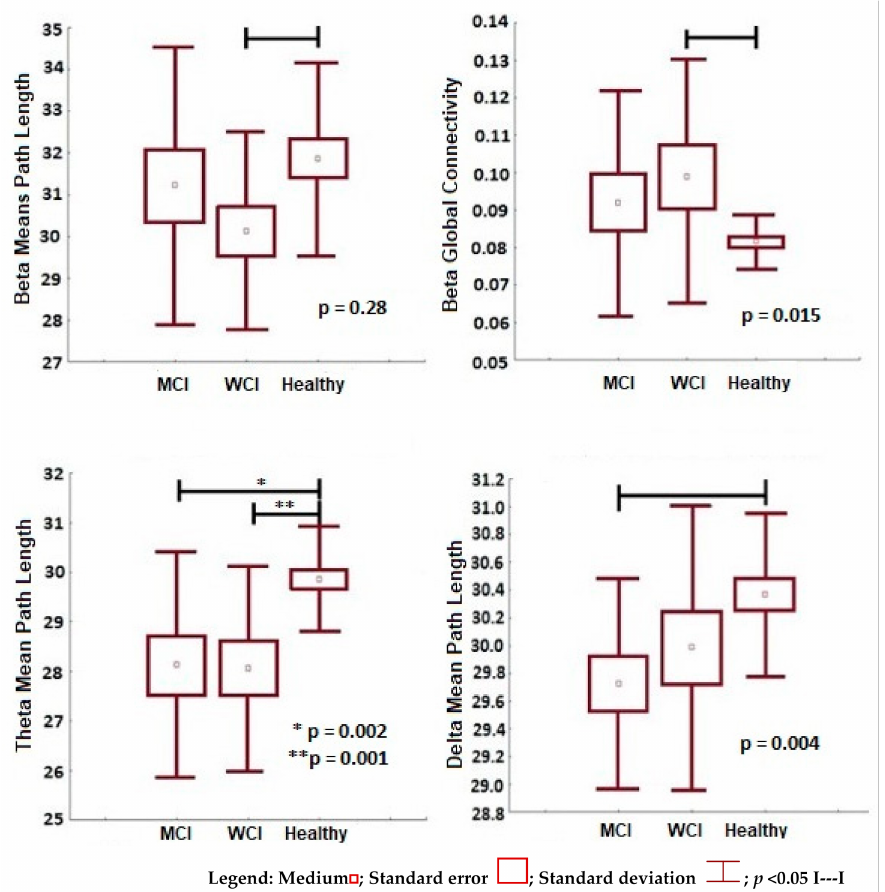
Figure 3. Functional integration variables (beta mean path length, beta global connectivity, theta mean path length, delta mean path length) with significant differences between the groups (healthy subjects, PD-WCI, PD-MCI). Mann–Whitney U, significance value p <